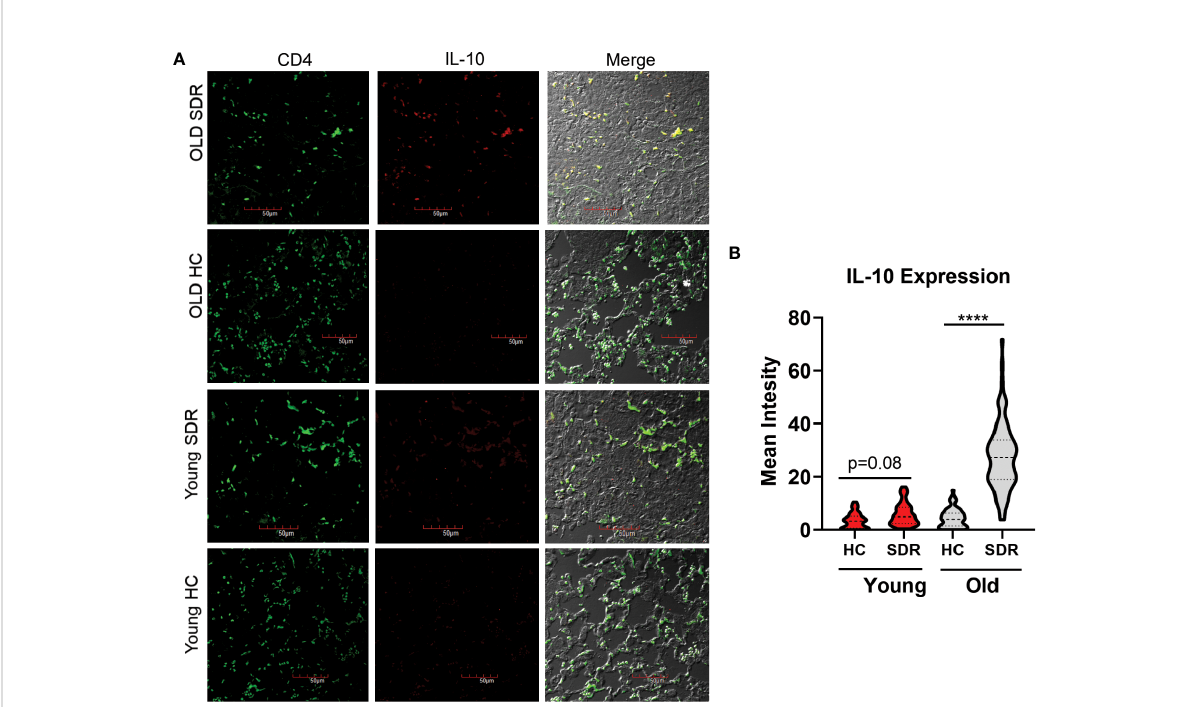
FIGURE 8 SDR in old mice results in production of IL-10 by CD4 + T cells in the lungs of M.tb infected mice. Lung tissues sections from mice infected with M.tb for 60 days were examined by confocal immuno fl uorescence microscopy for expression of IL-10 (red fl uorescence) in CD4 + T cells (green fl uorescence) present in areas of pneumonia. (A) Representative images of IL-10 expression in CD4 + T cells. (B) Mean fl uorescence of IL-10 expression in CD4 T cells was determined using Image (J) N= 90 cells/group. Statistical analysis was performed by one-way ANOVA with Tukey multiple-comparisons post hoc test. **** p <